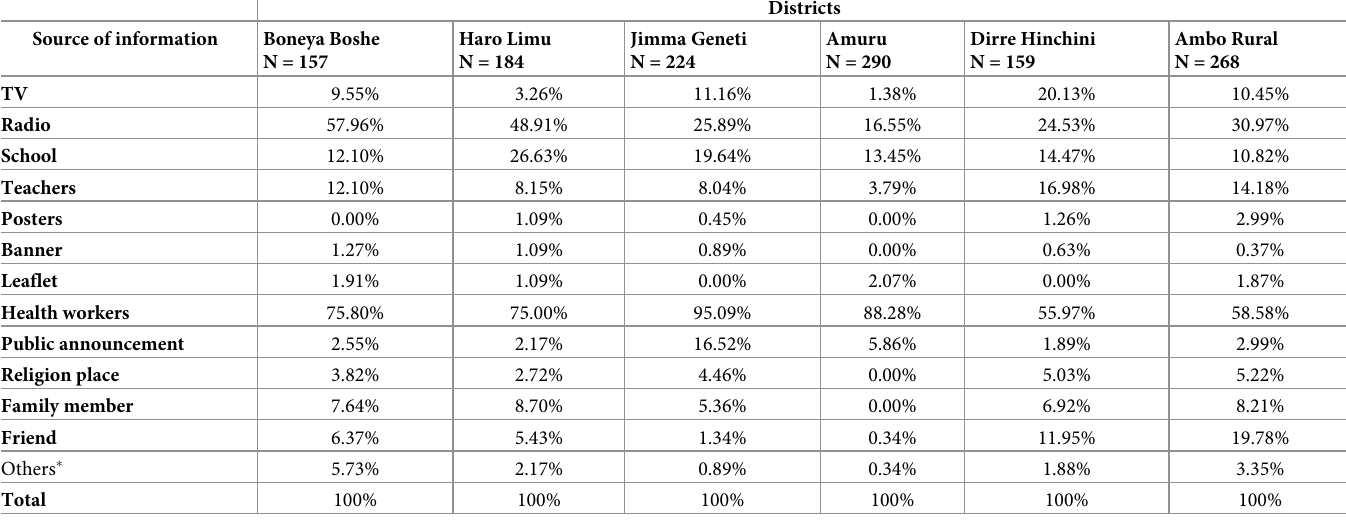
Table 3. Source of nformation about trachoma as reported by respondents, in six districts of East Wollega, Horo Guduru Wollega, and West Shewa zones of Oro- mia,